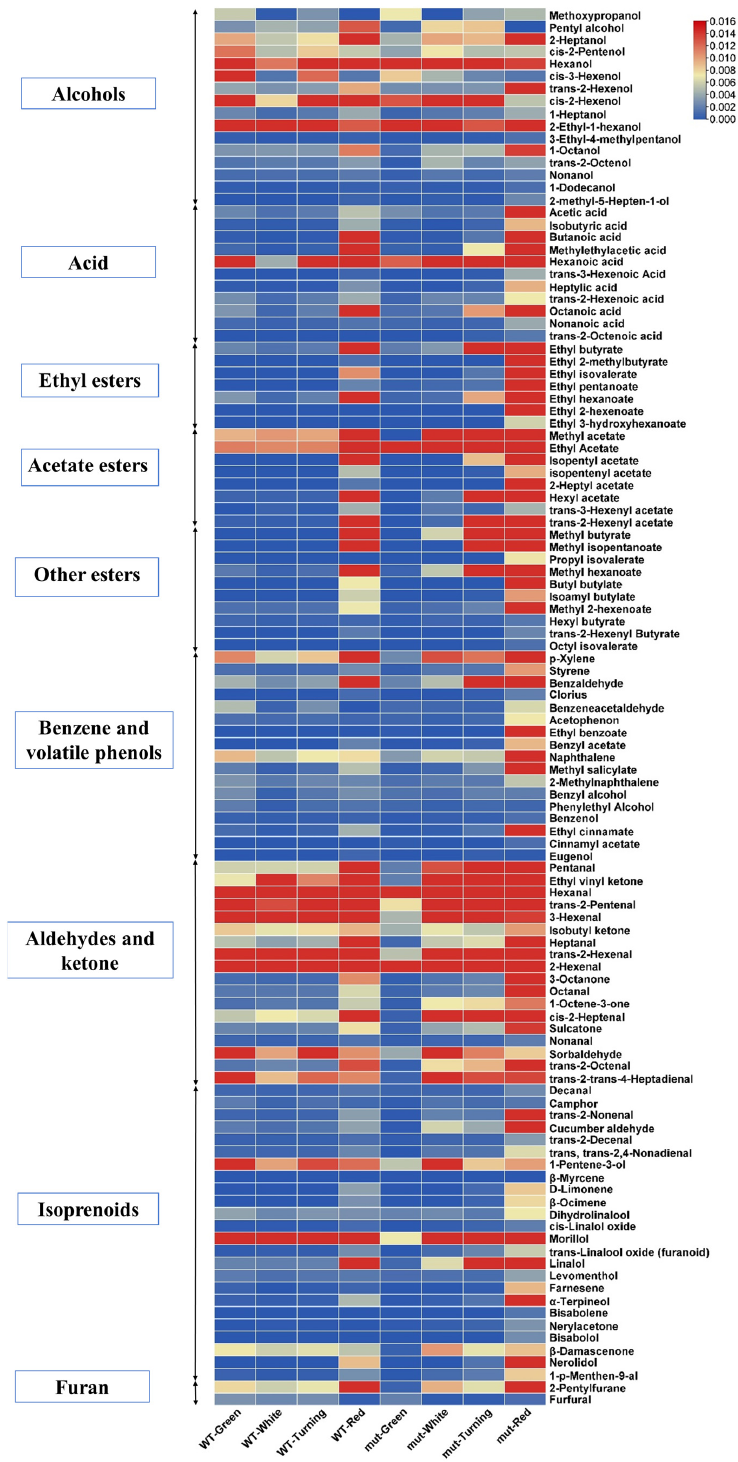
Figure 2. Heatmaps of volatile compounds in different developmental stages of ‘Benihoppe’ and ‘Xiaobai’. Darker red indicates a higher compound content. Darker blue indicates a lower compound content. (WT: ‘Benihoppe’; mut: ‘Xiaobai’).